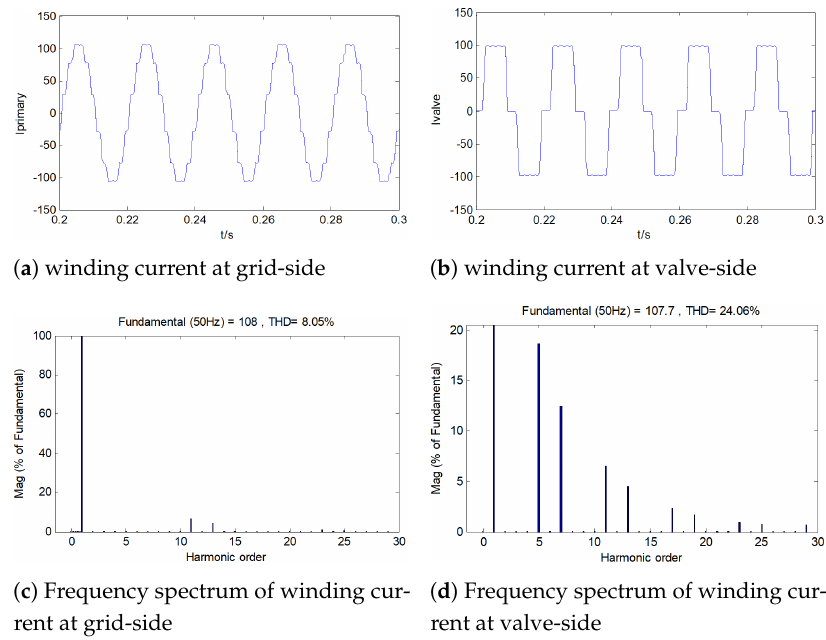
Figure 7. Waveformand frequency spectrum of winding current from the valve-side and grid-side on the left column of the converter transformer under working condition